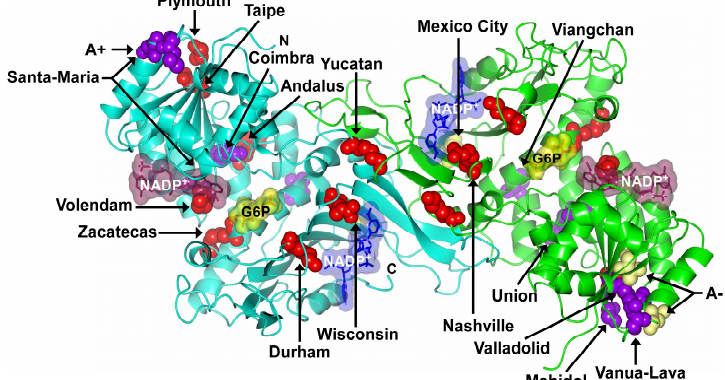
Figure 2. Location of single nucleotide substitutions (missense variants) in G6PD structure showing Class I (red spheres), Class II (purple spheres), and Class III (yellow spheres) mutations. Note that the illustration only shows Zacatecas, Durham, Yucatan, Viangchan, Coimbra, Volendam, Mexico City, Vanua ‐ Lava and Taipe mutants on equivalent positions of the G6PD dimer.